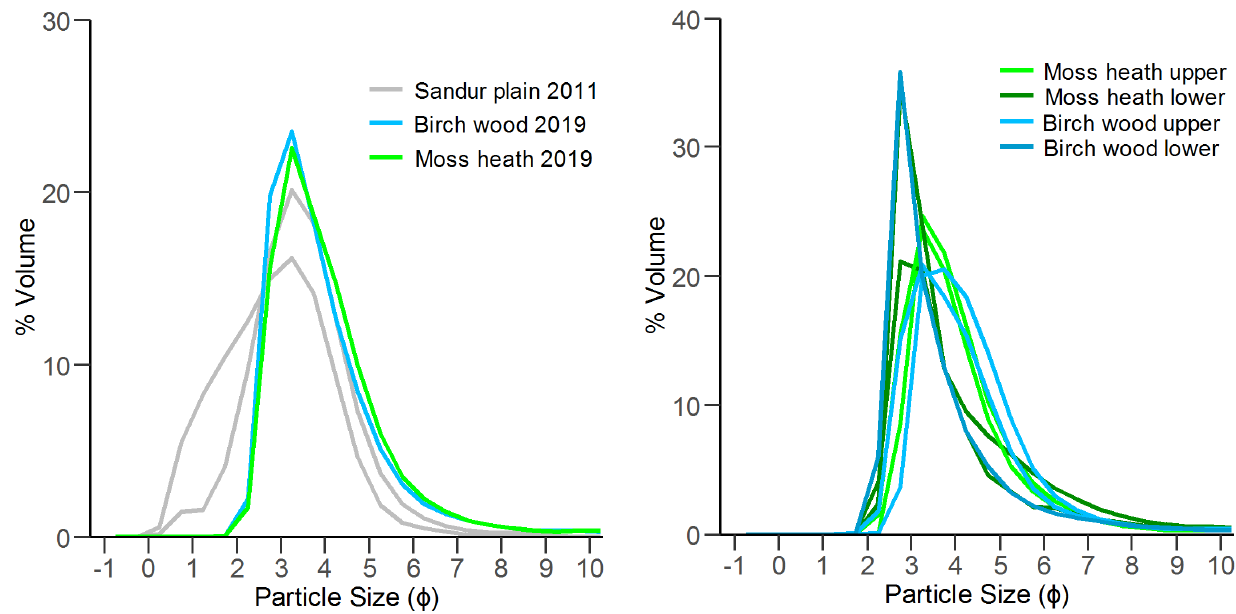
Figure 9: Grain-size distribution plot for samples of G2011 taken at Fossdalur, showing samples taken from different veg- etation types and portions (moss heath: upper = 2, lower = 2; birch wood: upper = 2, lower =